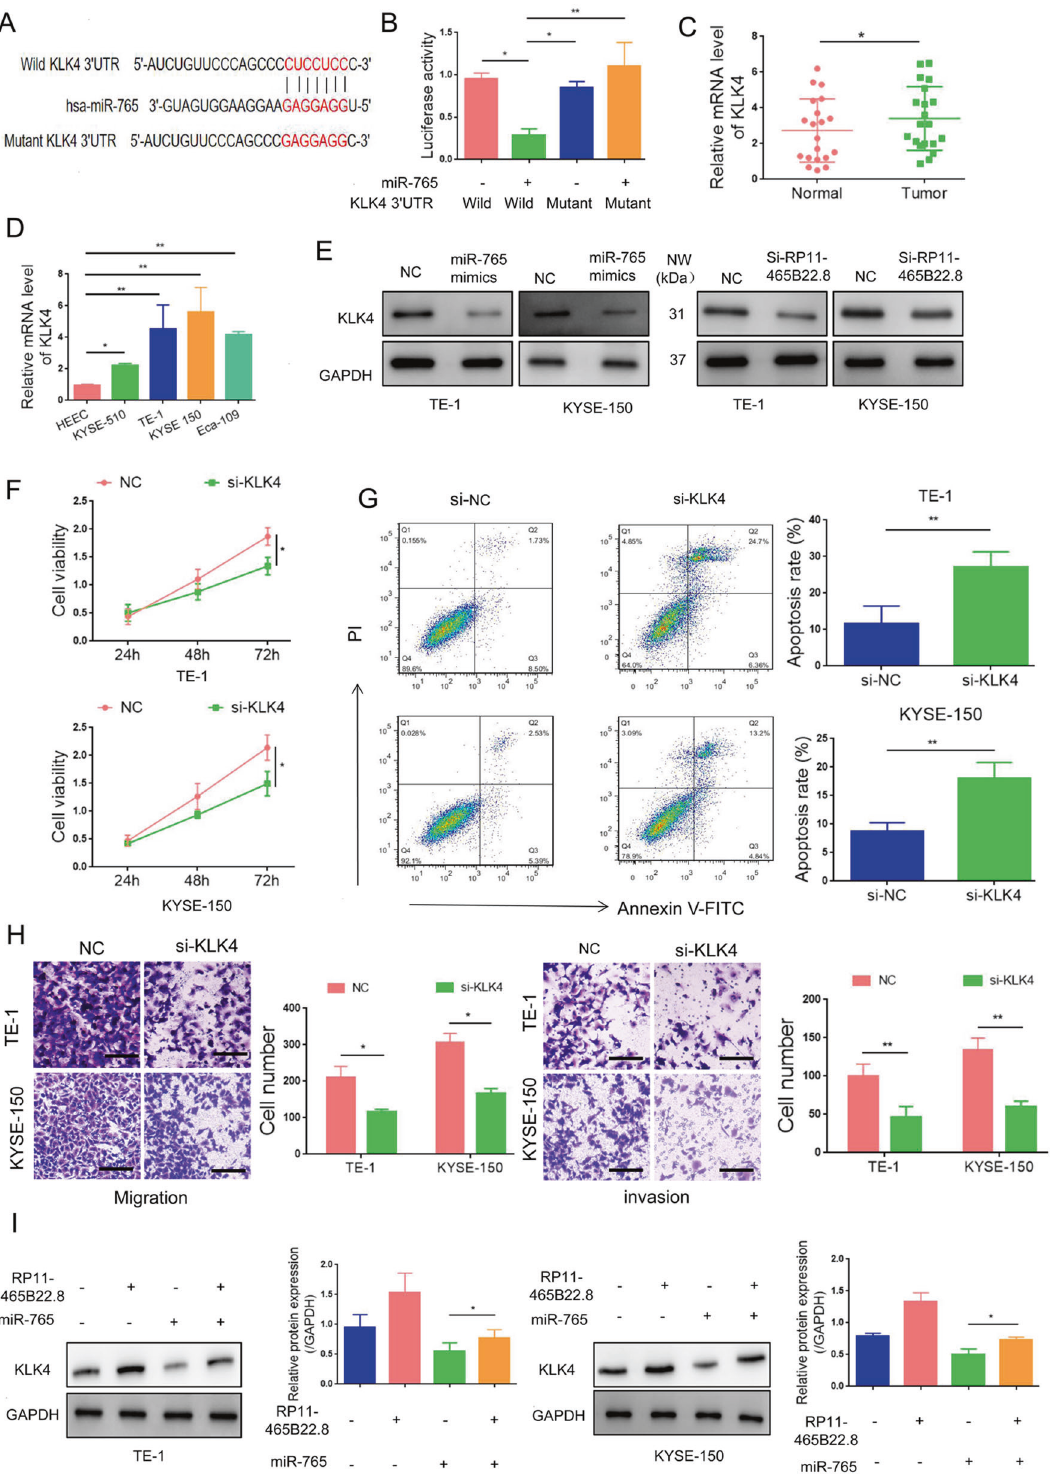
Fig. 5 LncRNA RP11-465B22.8 promotes EC cell proliferation and migration by targeting miR-765/KLK4 axis. A The predicted binding sites of miR-765 in KLK4 3 ′ UTR. B Luciferase reporter assay in HEK293T cells transfected with miR-765 together with the wildtype (wild) or mutated KLK4 3 ′ UTR (Mutant). C , D qRT-PCR analysis of miR-765 expression in EC tissues ( n = 20) and cell lines. E qRT-PCR analysis of KLK4 expression in EC cells transfected with miR-765 mimics. F qRT-PCR analysis of KLK4 expression in EC cells transfected with lncRNA RP11-465B22.8. G The cell viability of EC cells transfected with si-KLK4. H The apoptosis rate of EC cells after KLK4 silencing. I The migration ability of EC cells with KLK4 knockdown. J Transfection with miR-765 blocked the promoting effect of lncRNA RP11-465B22.8 on KLK4 expression. * P < 0.05, ** P < 0.01.